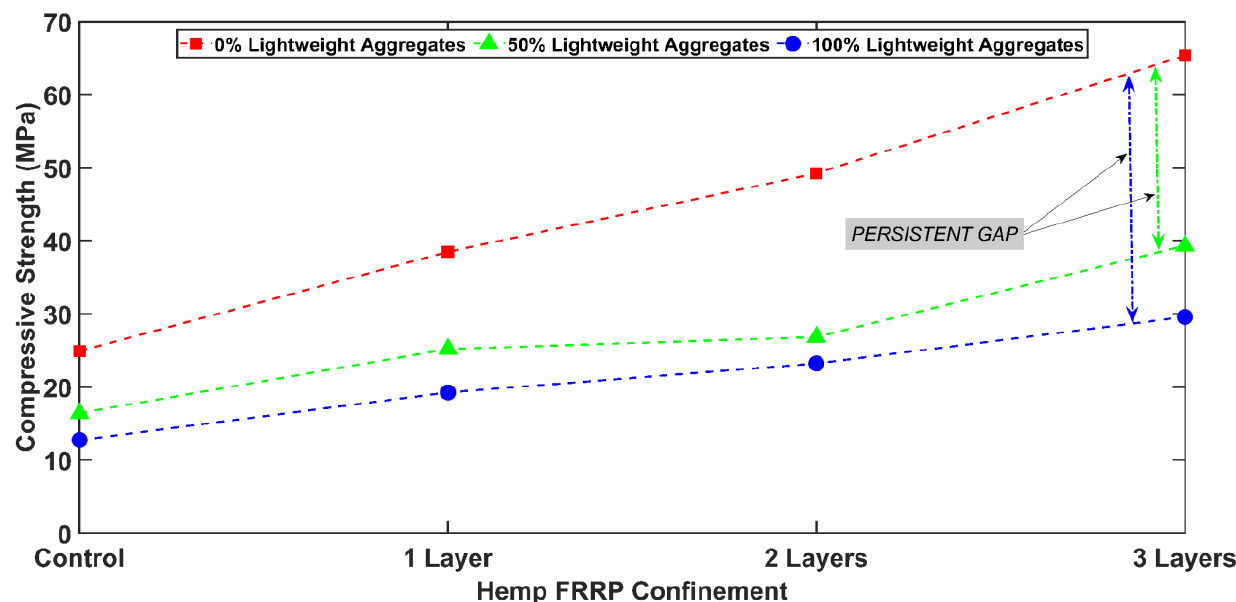
Figure 8. Comparison of the compressive strengths between different groups (function of the amount of hemp FRRP).